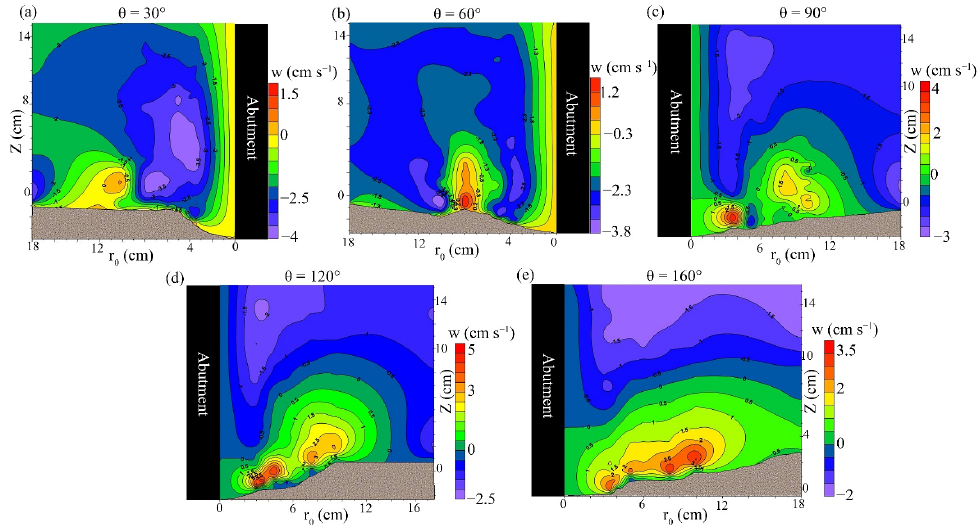
Figure 13. Velocity field in the vertical direction ( w , cm/s) for the case of the vegetated bed at different azimuthal angles of θ . Note that the range of the color scale is not equalized for better illustration.